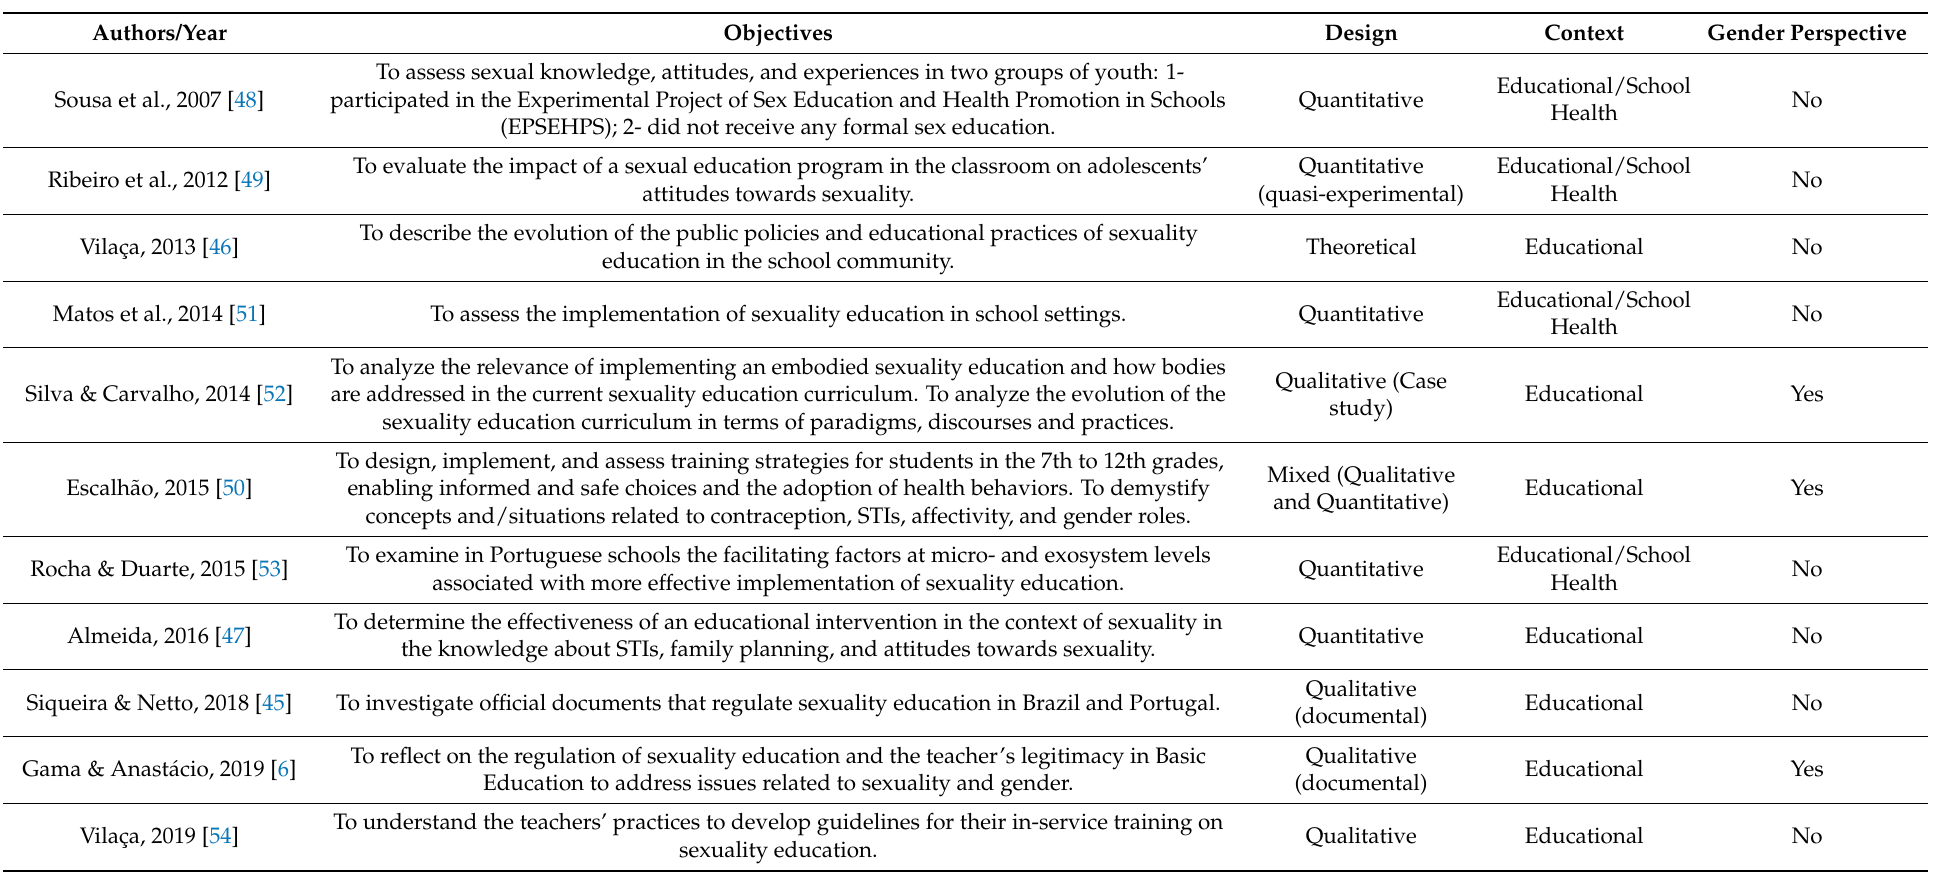
Table 2. Characteristics of the studies conducted in